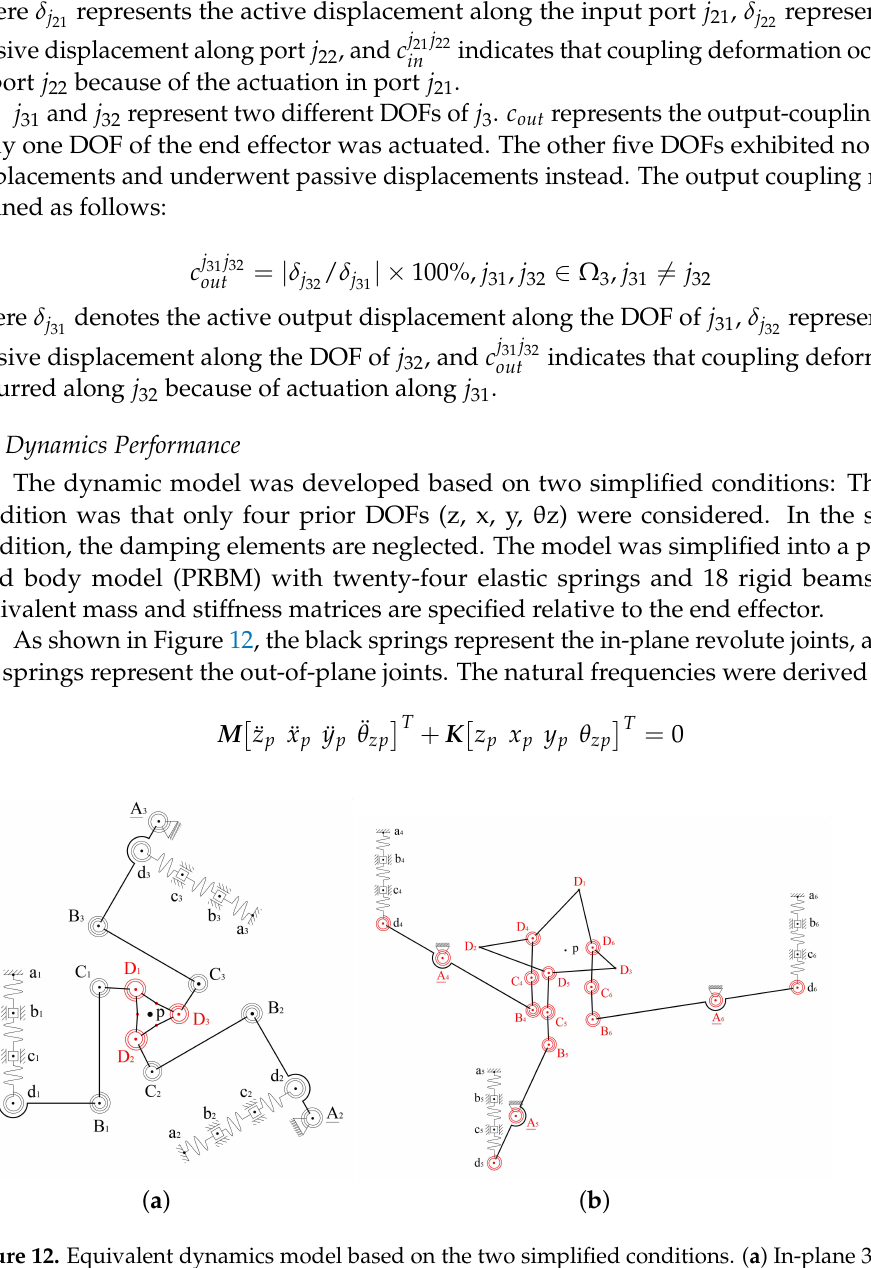
Figure 12. Equivalent dynamics model based on the two simplified conditions. ( a ) In-plane 3-RRRR; ( b ) out-of-plane